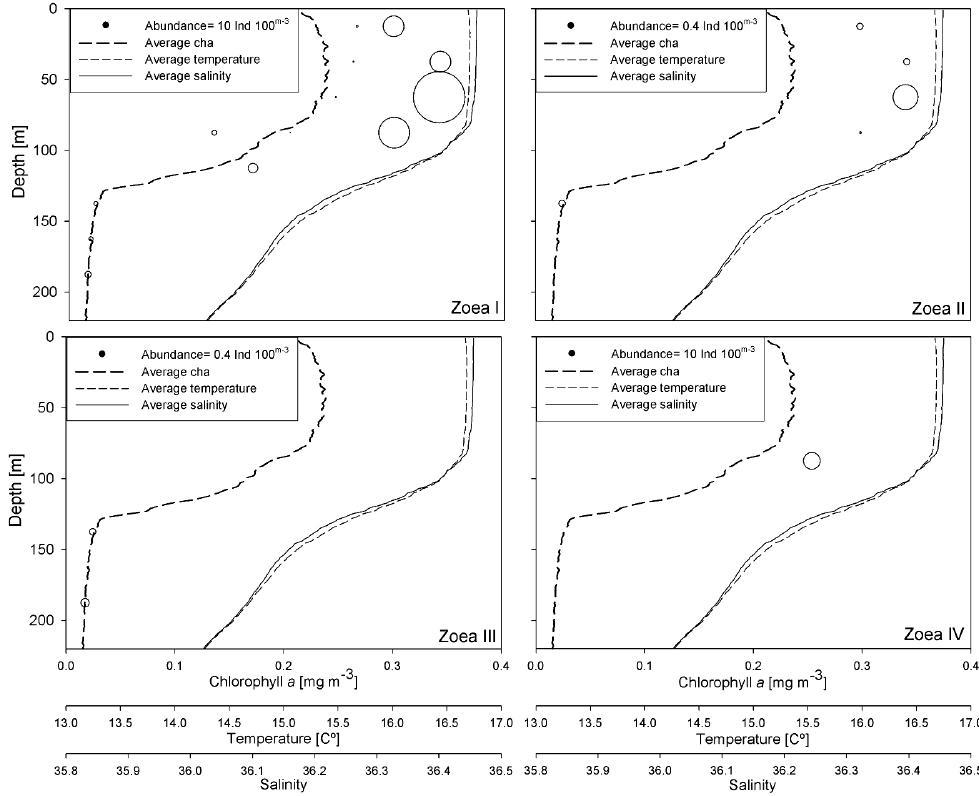
Fig. 5. – Monodaeus couchii . Standardized catch of zoea plotted as a function of depth (m) and chlorophyll a concentration (mg m –3 ) during the 2007 cruise off the coast of Algarve. The size of the circle represents larval abundance. The lines represents the average profile of chloro- phyll a , temperature (°C) and salinity concentration calculated from measurements made at all the